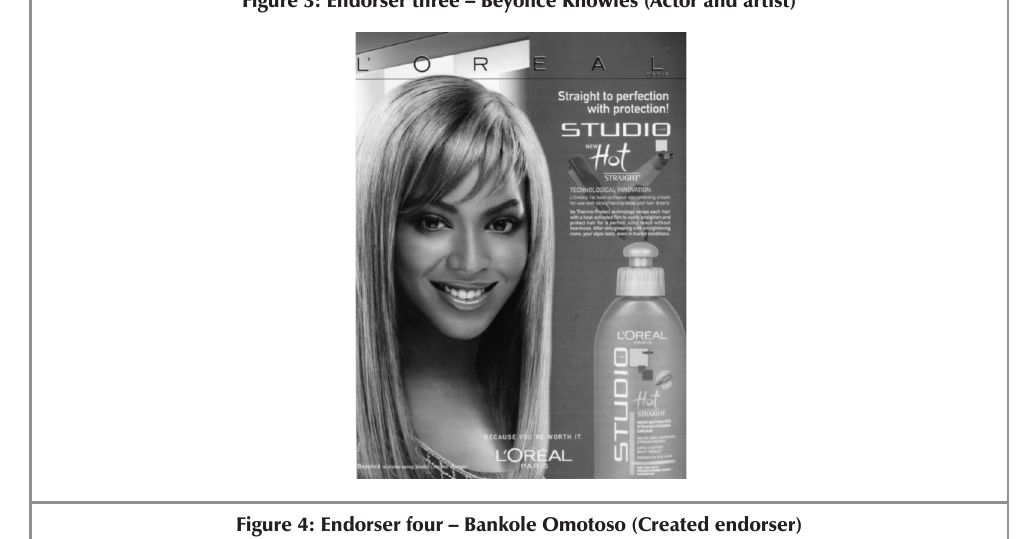
Figure 4: Endorser four – Bankole Omotoso (Created endorser)